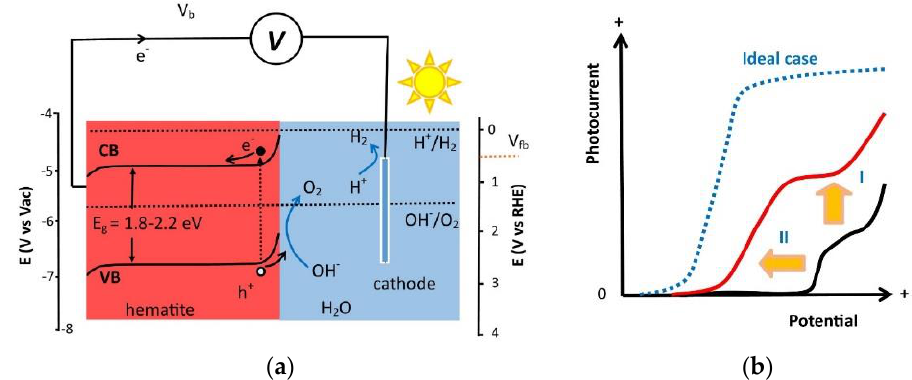
Figure 1. ( a ) Energy diagram for solar water splitting with a hematite photoanode performing the oxygen evolution reaction (OER) and a cathode carrying out the hydrogen evolution reaction (HER). The hematite bandgap (E g ), the flatband potential (V fb ), the applied bias (V b ), and the redox potential of water are indicated; ( b ) photoelectrochemical performance improvement of the hematite photoanode via surface modification. Arrow I indicates a photocurrent increase, arrow II indicates a photocurrent onset potential shift. The blue dotted line shows an idealized photocurrent vs. potential (I-V) of the hematite photoanode. The red line shows the I-V curve after surface modification while the back curve shows that of as prepared.